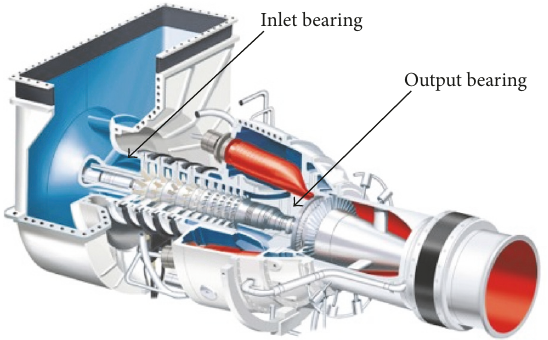
Figure 1: Locations of IGT bearing vibration